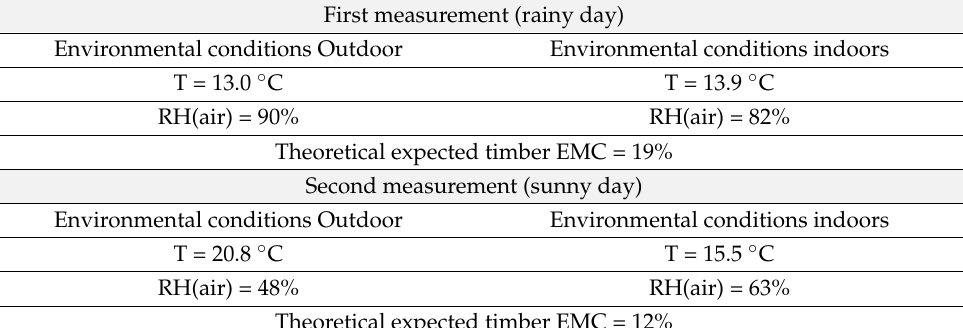
Table 4. Result of outdoor and indoor measurements of environmental conditions and expected timber EMC.